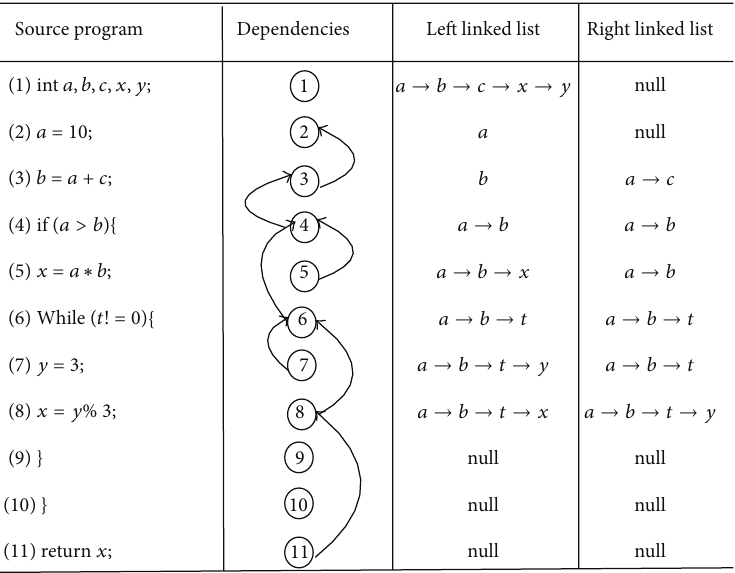
Figure 1: An example of data dependencies definition.